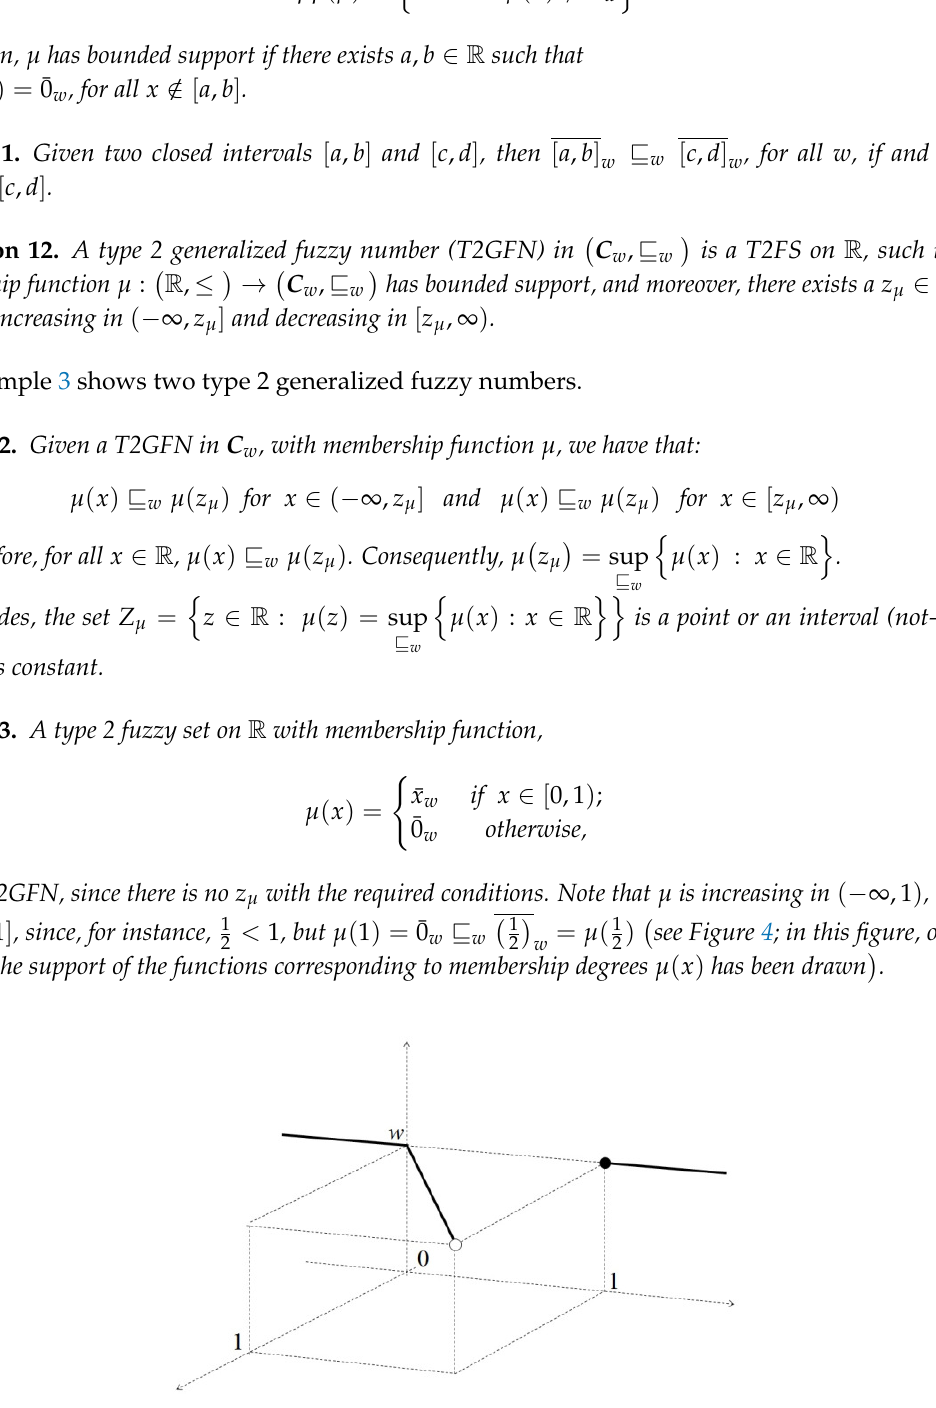
Figure 4. Example of a type 2 fuzzy set (T2FS) that is not a type 2 generalized fuzzy number